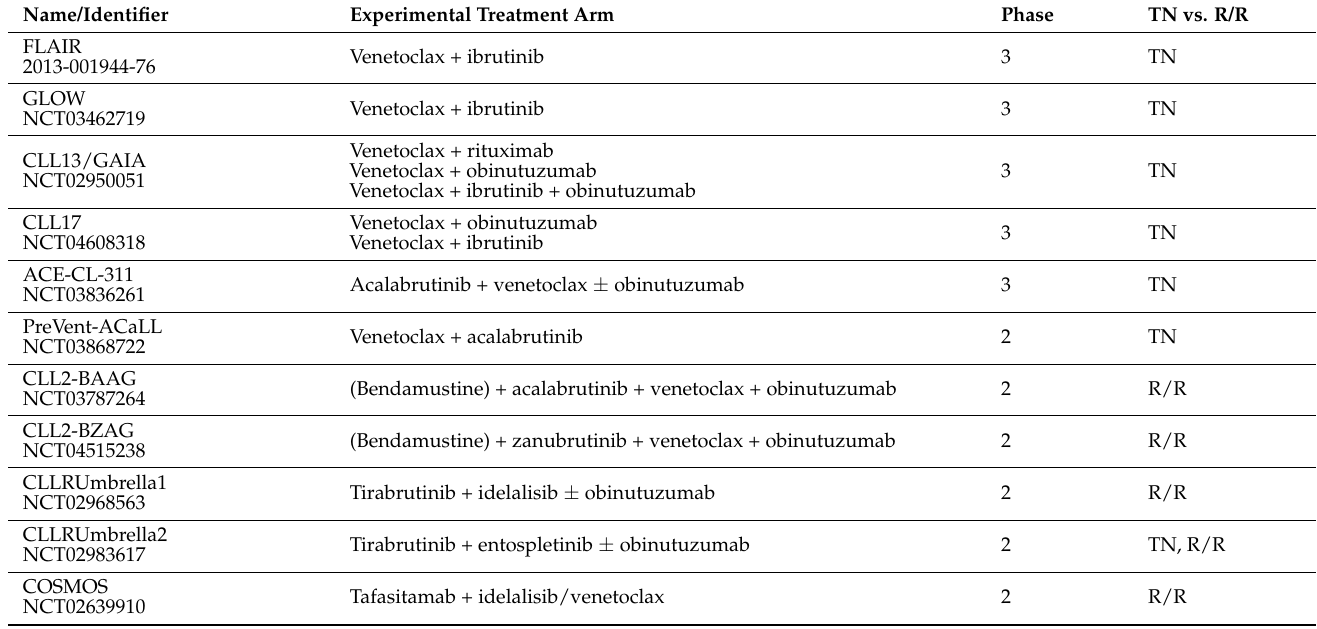
Table 2. Selected currently ongoing studies assessing time-limited combination